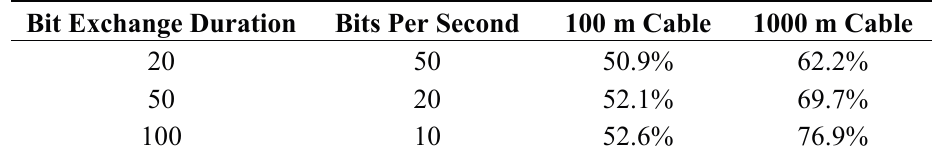
Table 1. Attack simulation results—Eve’s success rate p E (%) with 1000 bits key length.